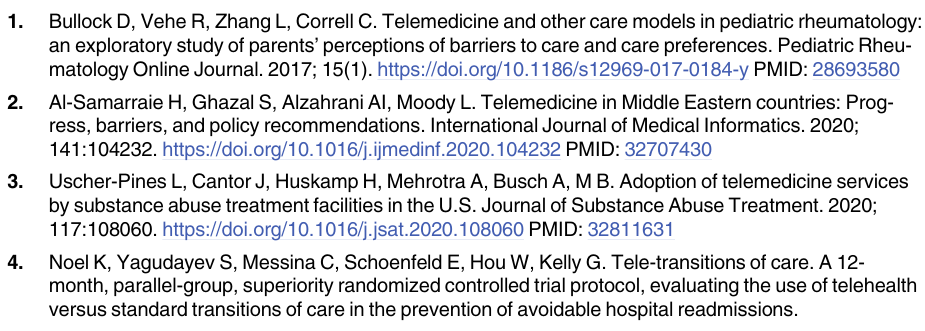
S1 Table. Demographics characteristics of the sample and survey